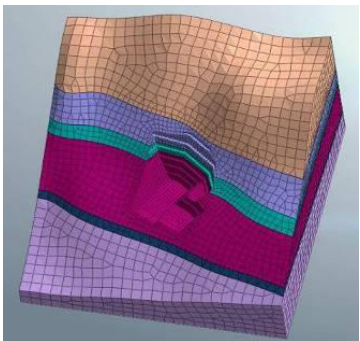
Figure 5. The meshing of surrounding rock.